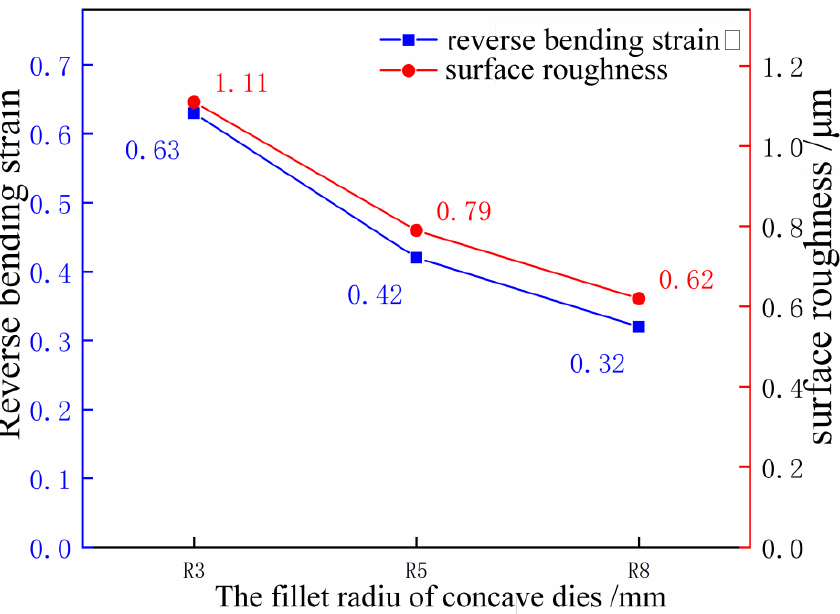
Figure 18. Reverse bending strain and surface roughness change curves at different die fillets.